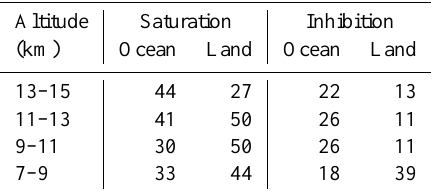
Table 4. Percent of the observations indicating saturation and inhi- bition effects as MODIS AODs increase.